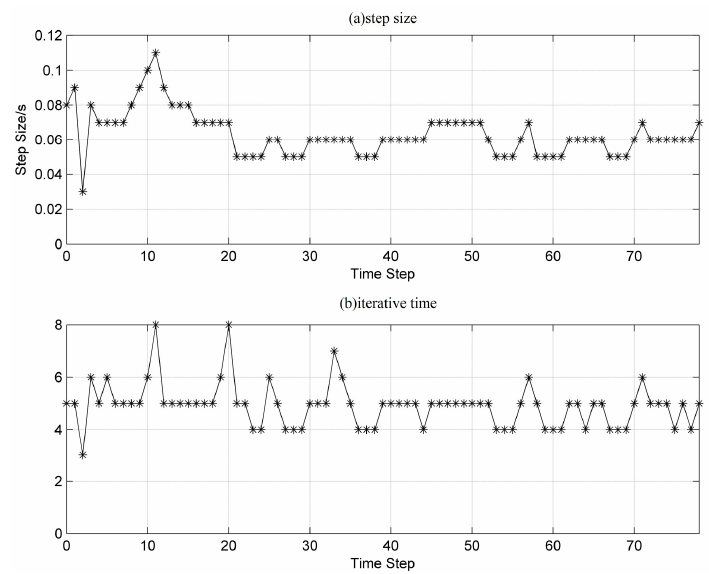
Figure 12. The variation in the step size and iteration times using VSVII in case B.